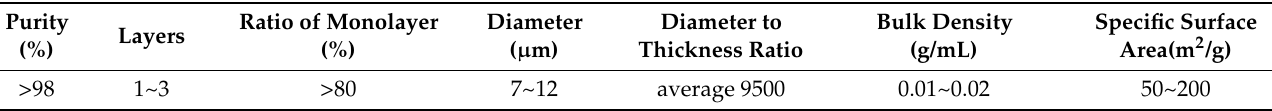
Figure 1. Microtopography of graphene. Table 4. Performance of graphene.